Question: What does this figure show? Answer in one sentence.
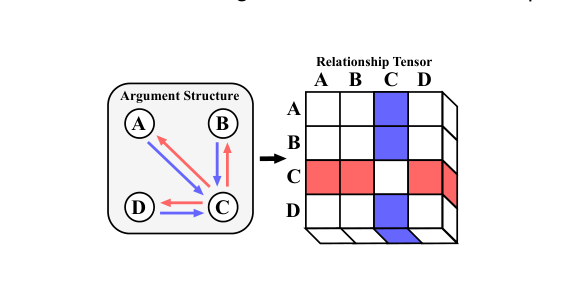
Answer: We select argument C as the observa- tion object. This example shows the correlation between the head (red) and tail (blue) relationship information and a relationship tensor. Each ele- ment in this relationship tensor is the concatenation of two arguments.